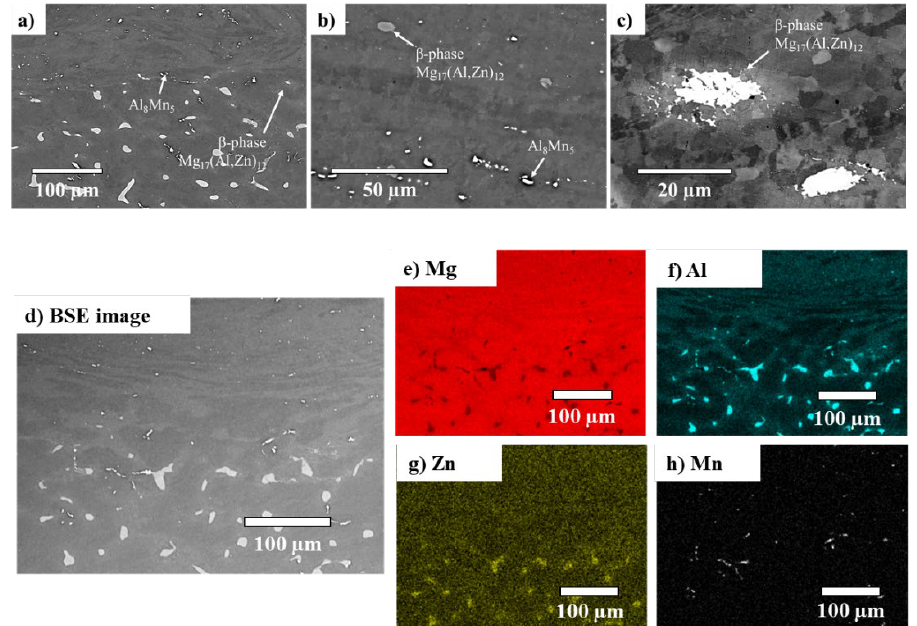
Figure 7. AZ91/AZ91 weld. SEM micrographs of ( a ) the transition between the base material (bottom) and the central weld zone (top), ( b ) the central weld zone, and ( c ) a β –Mg 17 (Al, Zn) 12 particle located close to the central weld zone. Start of central weld zone in the AZ91/AZ91 weld ( d ) is shown along with its EDS elemental maps ( e – h ). Al and Zn concentrated initially at the β –Mg 17 (Al, Zn) 12 phase, while Mn remained in the Al 8 Mn 5 phase. After welding, they dissolved into the Mg